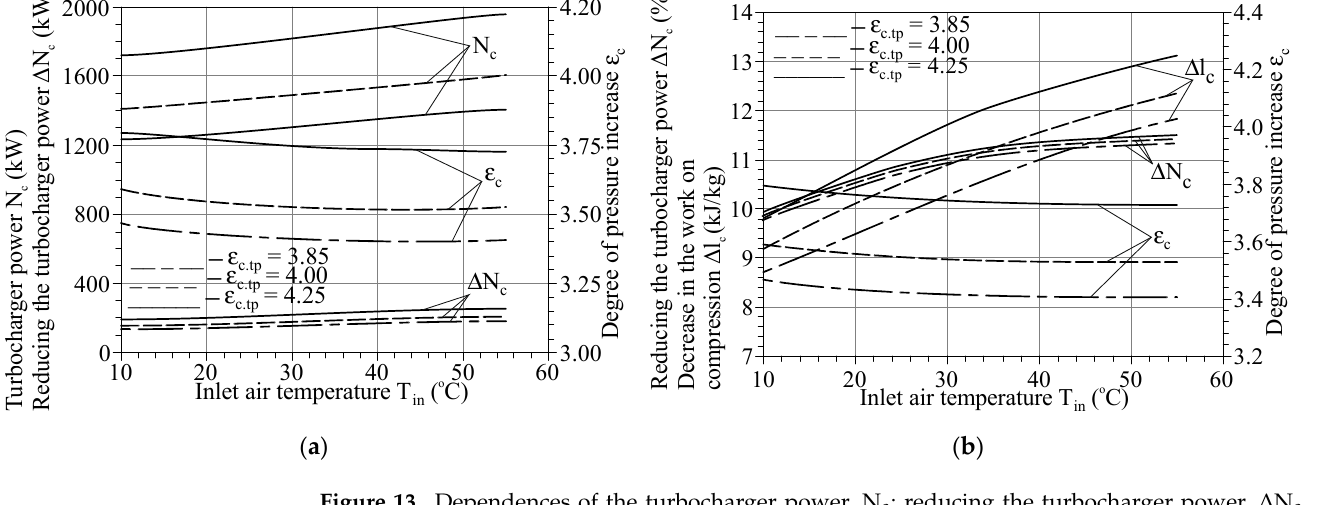
Figure 13. Dependences of the turbocharger power, N c ; reducing the turbocharger power, Δ N c ( a ); decrease in the work on compression, Δ l c ; the decrease in the power of the T С , Δ N c ; the degree of pressure increase, ε c , ( b ) at different total pressure increase, ε c . tp , on the inlet air temperature, T in . At the minimum temperature at the thermopressor outlet, t tp2 , the temperature was taken to be 2–3 °C higher than the dew point temperature. It was taken into account that water injection continues in the thermopressor until the air is completely saturated, that is, φ = 100%. The decrease in the air temperature is Δ t tp = 110–160 °C, which makes it possible to increase the air pressure by ΔР tp ' = 520–670 kPa (15–18%) (Figures 14 and 15) with “ideal” compression (without taking into account losses friction against the channel walls), and ΔР tp = 340–480 kPa (10–13%) is the actual compression in the thermopressor (Figures 15 and 16). In this case, the degree of the air temperature decrease in the thermo- pressor will be T tp1 /T tp2 = 1.30–1.45 (Figure 16). The thermopressor uses as a second stage of compression in the pressurization system, and therefore it is appropriate to evaluate its efficiency by the degree of pressure increase, ε tp = 1.10–1.13.